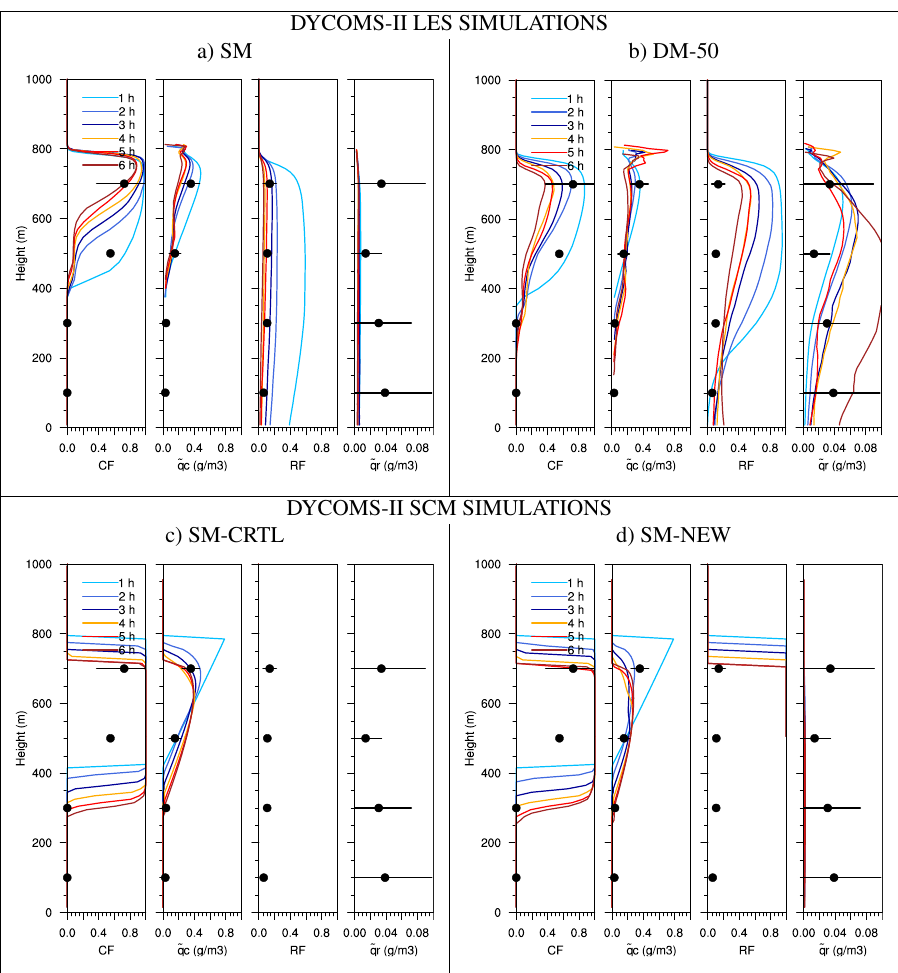
Fig. 6. Vertical profiles of cloud fraction (CF), cloud water content ( e q c ), rain fraction (RF) and rain water content ( e q r ) for LES and SCM simulations of DYCOMS-II. Mean values from observation are added with black dots and standard deviation with black lines. ￿ ￿